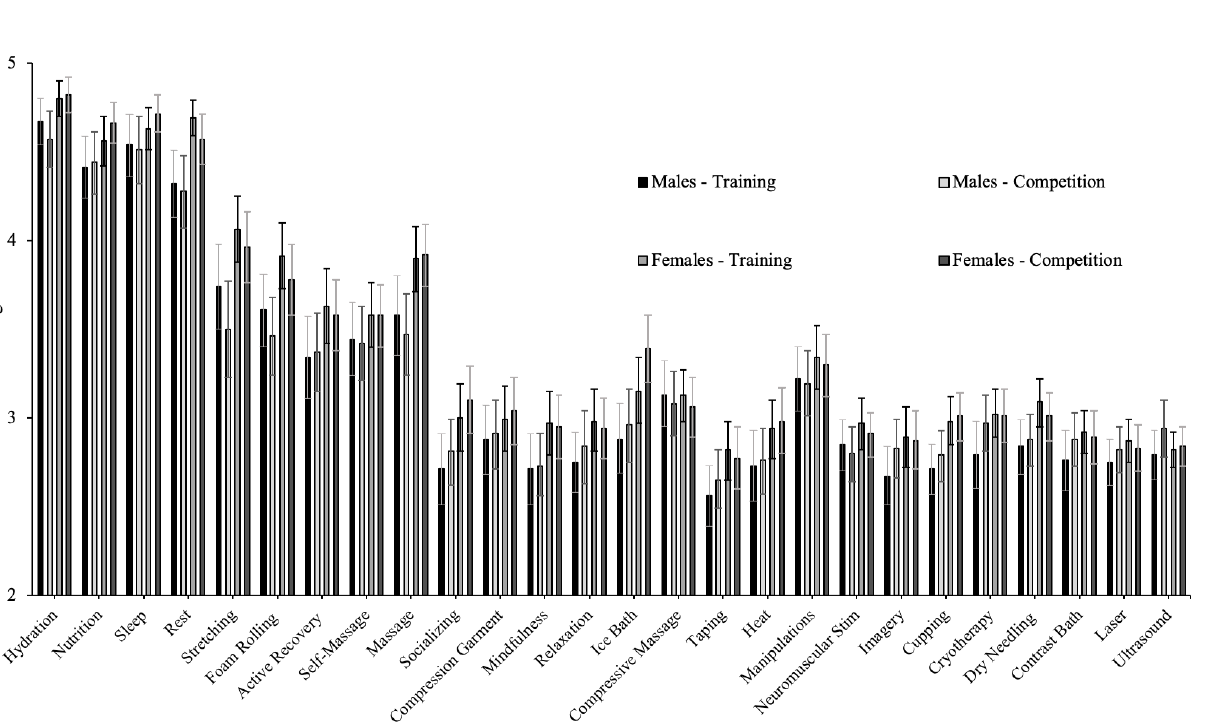
Figure 4. Ratings of recovery strategy effectiveness by sex. For training, female athletes had a significantly higher mean ranking for cryotherapy, contrast bath, rest, massage, active recovery, stretching, foam rolling, cupping, dry needling, and socializing. For competitions, females had had a significantly higher mean ranking for hydration heat, ice bath, massage, stretching, cupping, dry needling, and socializing.